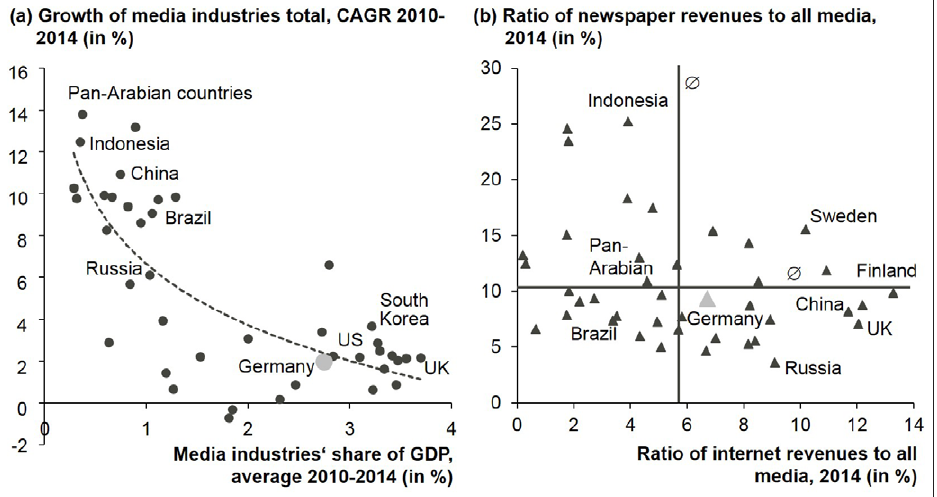
Figure 4: The role of newspaper industries in the overall media business of Germany in international comparison. Source : Own calculations on the basis of raw data from PWC